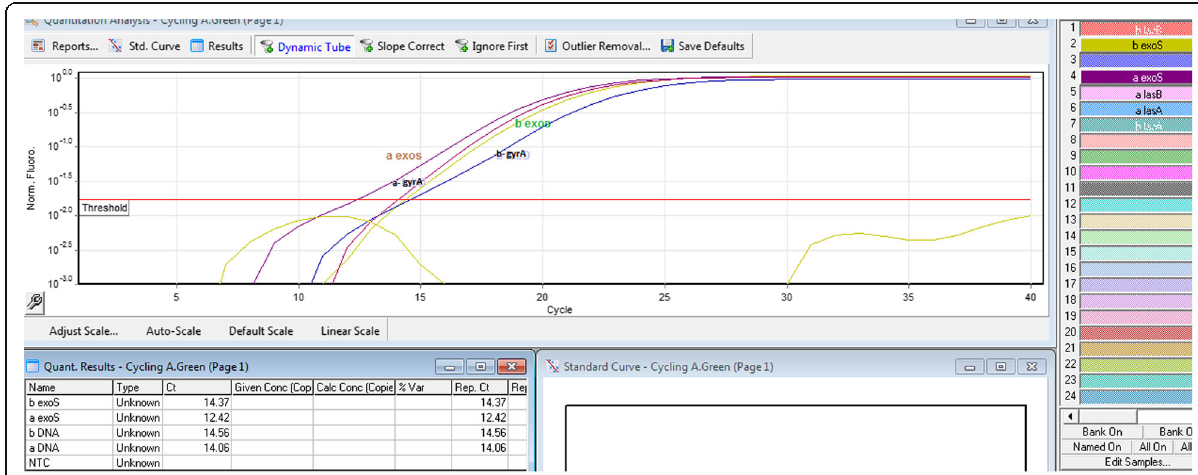
Fig. 1 exoS gene amplification curve using Real-time RT-PCR technique: As outlined in the figure, the Ct level of the exoS gene was different before and after treatment (Ct before treatment = 14.32 and Ct after treatment = 12.42). However, there was no change in the Ct level of the fabD gene before and after treatment (Ct before treatment= 14.56 and Ct after treatment= 14.06). Therefore, the amount of the exoS gene expression changed after treatment, while the FabD gene expression had no change before and after treatment